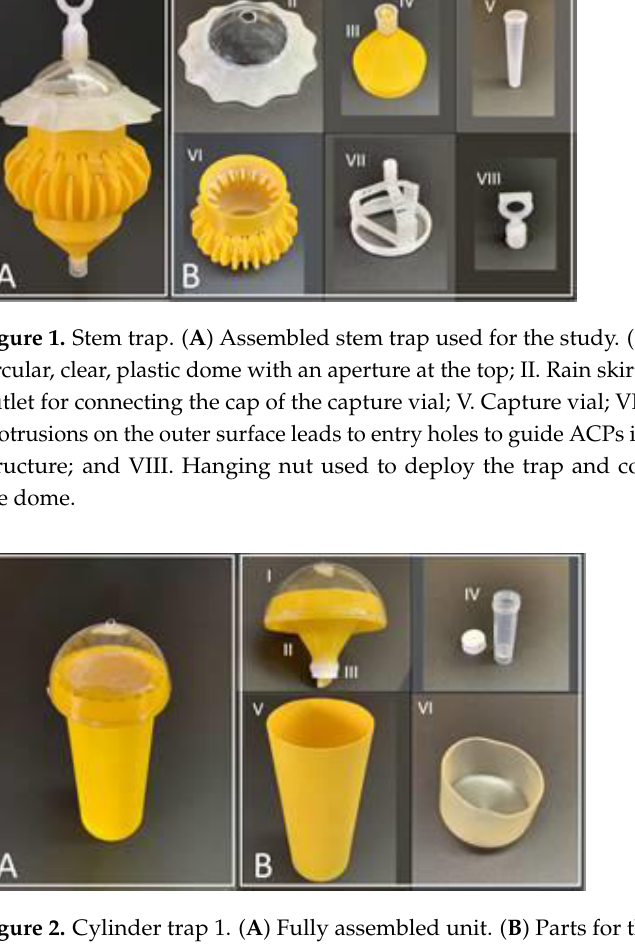
Figure 2. Cylinder trap 1. ( A ) Fully assembled unit. ( B ) Parts for the cylinder trap: I. Semi-circular plastic dome with a wire loop at the apical part for deploying the trap; II. Funnel with entry holes near the rim; III. The outlet of the funnel for connecting the cap of the capture vial; IV. Capture vial and cap; V. Body of the trap is sanded and painted bright yellow; and VI. Rubber covering for the open bottom end of the cylindrical body of the